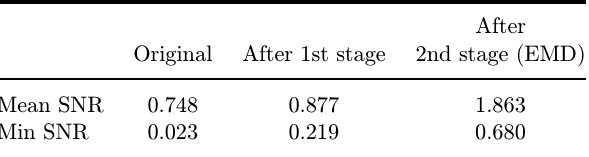
Table 1. SNR characterizations for 3D OCT image of implant on Fig.